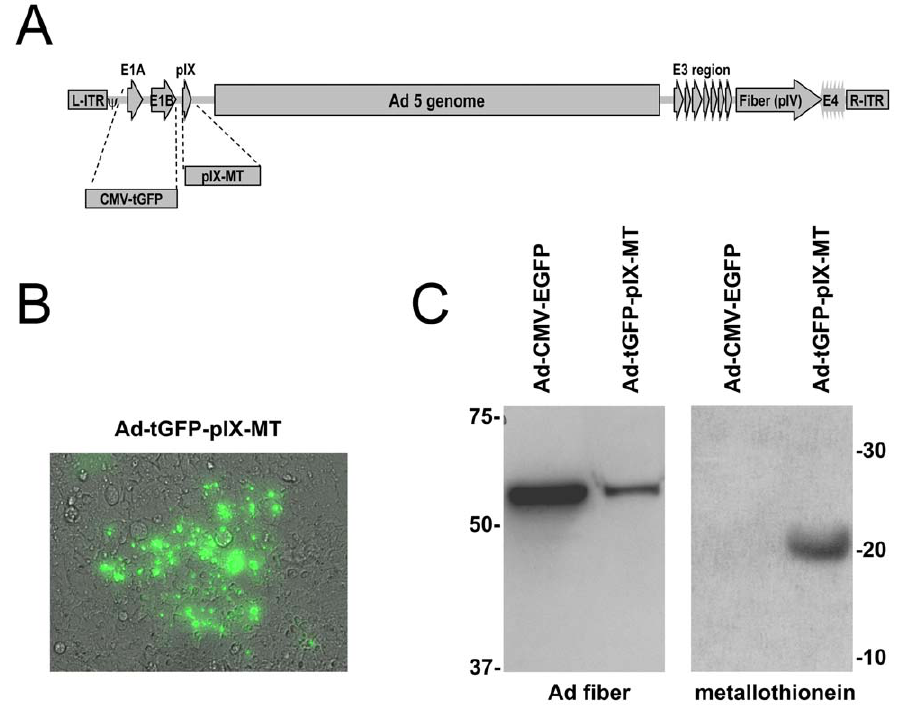
Figure 1. Construction and analysis of a pIX-MT containing adenovirus. (A) Schematic representation of pIX-MT and a CMV-tGFP expression cassette inserted into the Ad5 genome. (B) Expression of GFP in cells infected with Ad-tGFP-pIX-MT shows formation of an individual plaque. (C) Detection of adenovirus fiber and metallothionein proteins incorporated into the purified Ad-tGFP-pIX-MT and Ad-CMV-EGFP viral particles by western blot analysis.